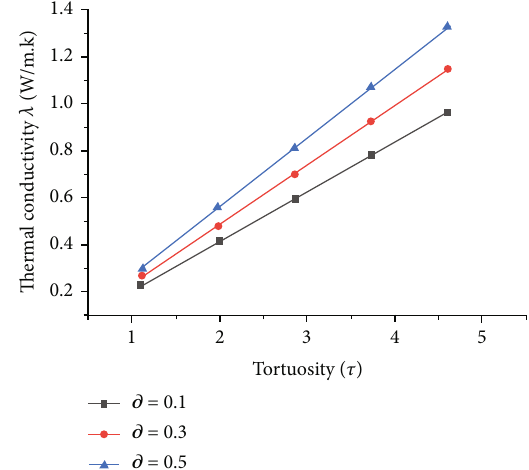
Figure 17: Relationship between thermal conductivity λ and tortuosity τ and tortuosity of the detailed volume-weighted average REV model with di ff erent ice content ∂